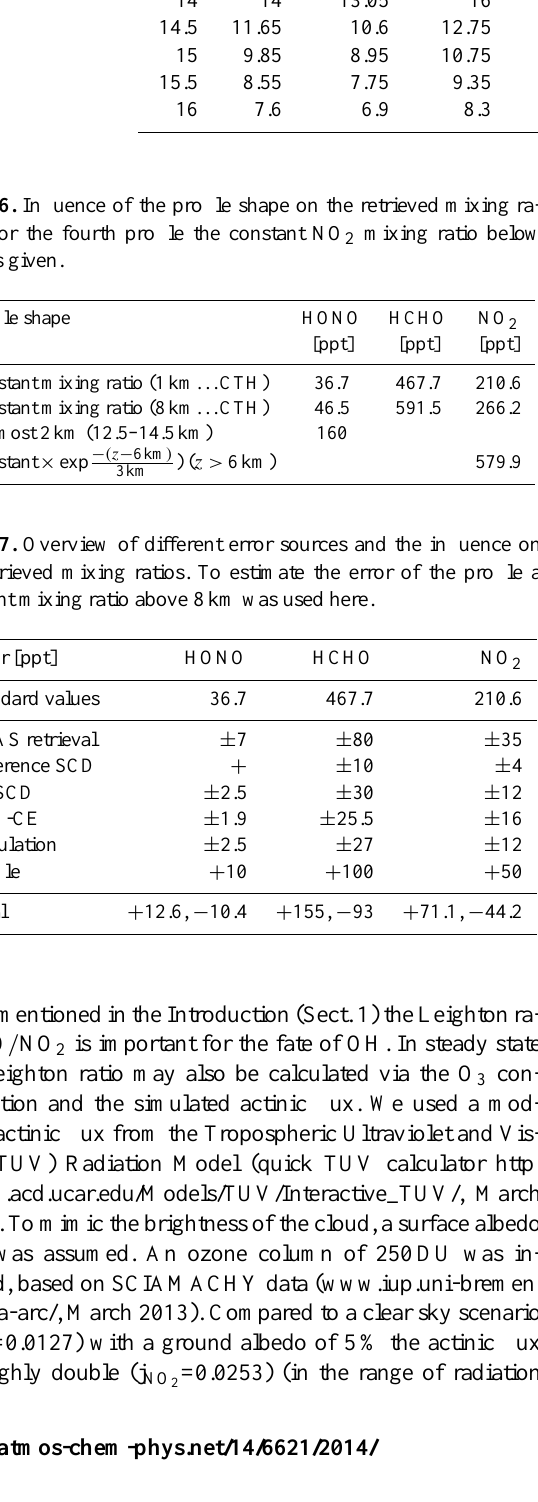
Table 5. Cloud extinction coefficients for O 4 SCD errors of − 15 and + 15%, and the corresponding range of mixing ratios for HONO, HCHO and NO 2 . For comparison the extinction coefficient for the uncorrected O 4 SCD is given. For a CTH of 13.5km, the cloud extinction is out of the range of the simulations, therefore no values are given for the respective mixing ratios. CTH CE CE CE CE HONO HCHO NO 2 ( − 15%) (+15%) (uncorrected) km km − 1 km − 1 km − 1